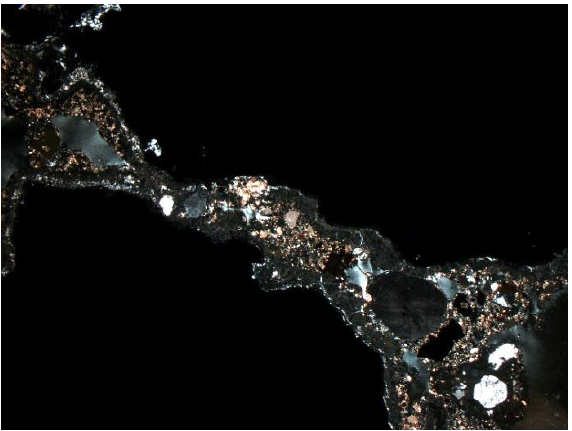
Figure 21. Metallic substance, shiny. SP2 sample, thin section, 2P, 100×, transmitted light.